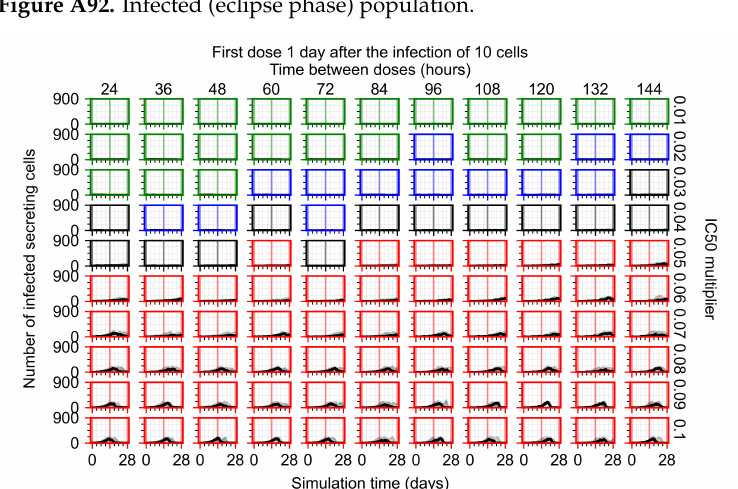
Figure A92. Infected (eclipse phase) population.